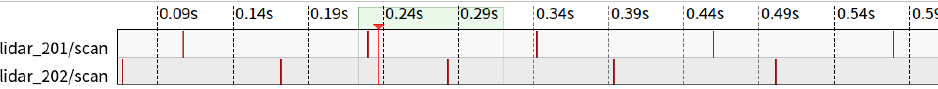
the two lidars. As the time offset is constant, an adaptive timestamp synchronization algorithm is used to solve it. The adaptive time synchronization algorithm is used to match its timestamp and realize the simultaneous localization and mapping of the lidars. The timestamps of the dual lidar is shown in Figure 4, where lidar_201/scan represents the timestamp of the horizontal lidar and lidar_202/scan represents the timestamp of the vertical lidar.